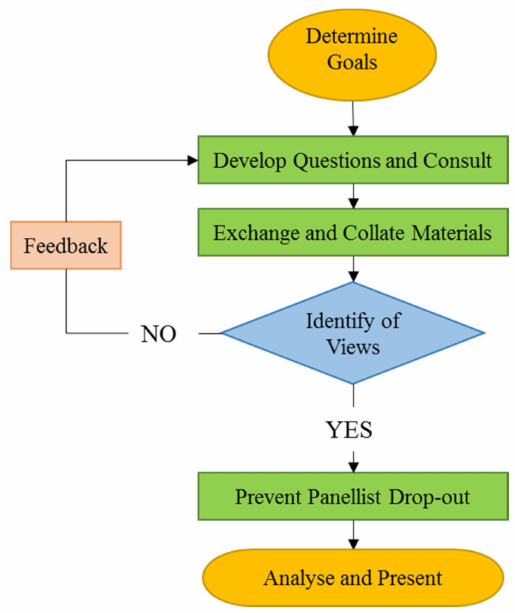
Figure 4. Delphi method